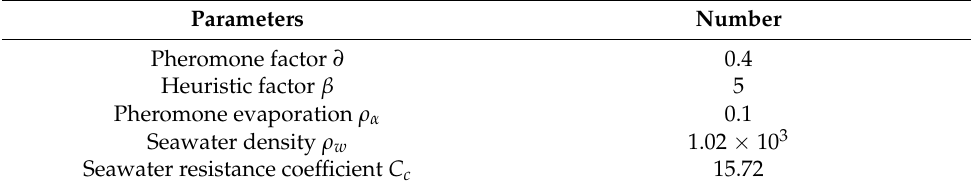
Figure 5. ( a ) Energy consumption of improved ant colony algorithm, and ( b ) energy consumption of traditional ant colony algorithm. Table 1. Related parameter